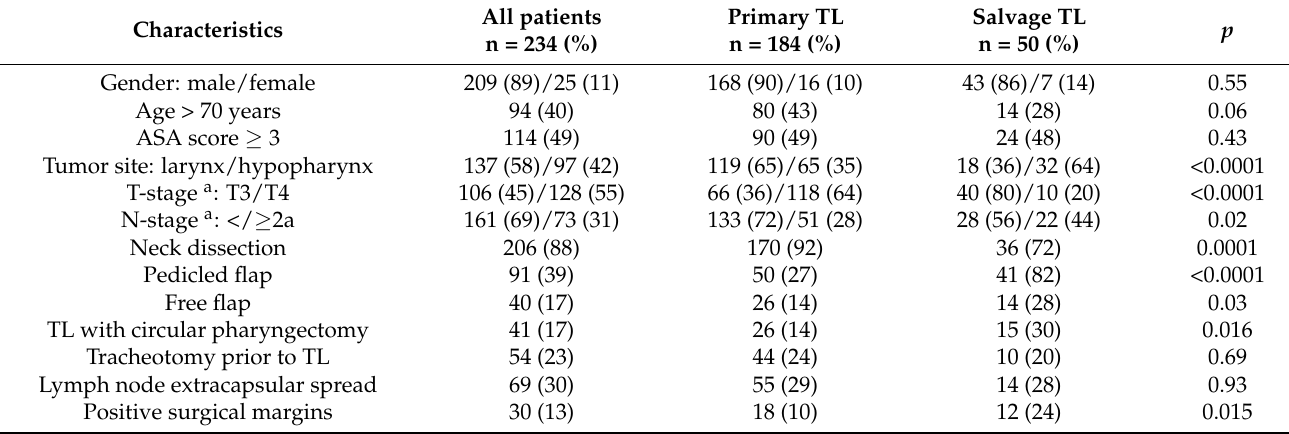
Table 1. Patients’ clinical characteristics according to the type of surgery.